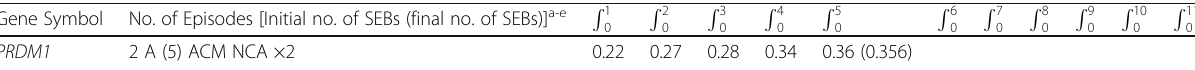
Table 4 Chromosome 6 (+) chromatin B-cell transcription factor adapter gene, PRDM1 , sequential esebssiwaagoT Q s to final 2-digit (and 3-digit) esebssiwaagoT Q Gene Symbol